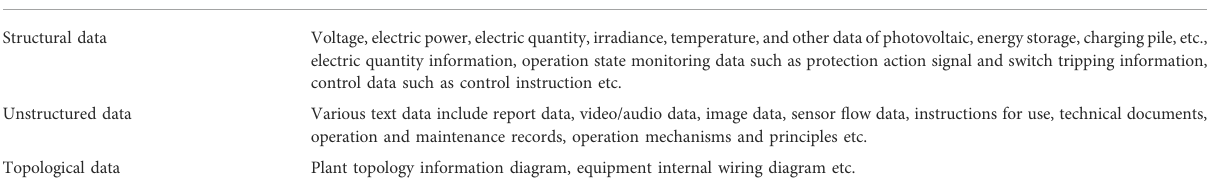
TABLE 1 Data type of electric power fusion. Types